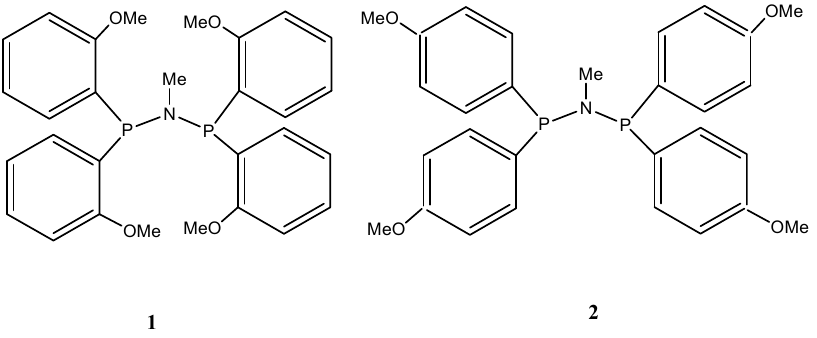
Figure 2. Ortho - and para -methoxyaryl PNP ligands.